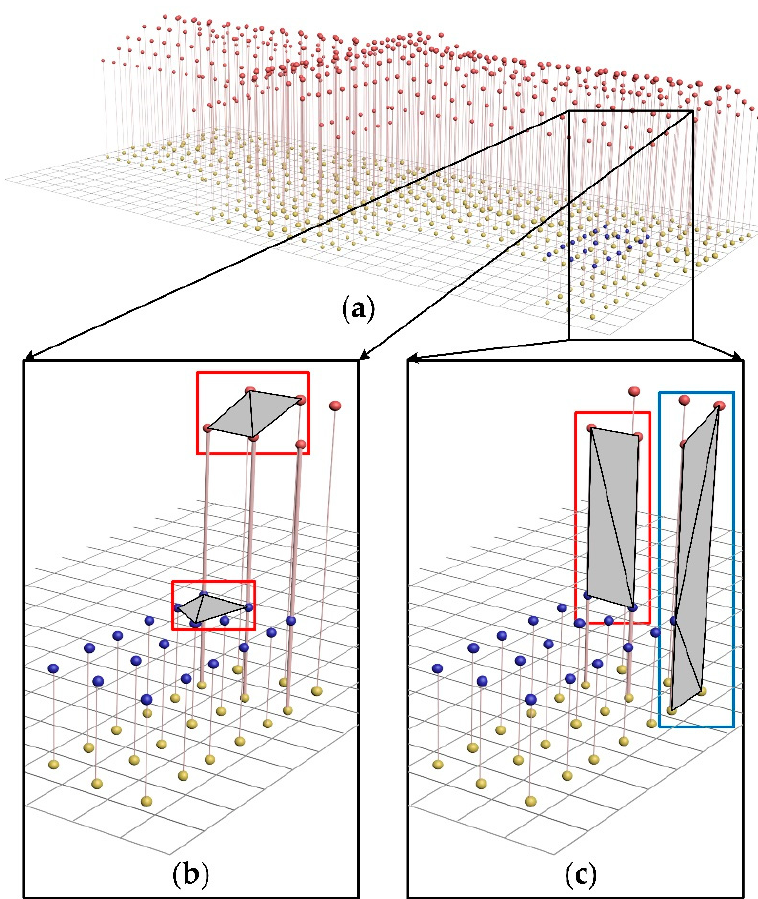
Figure 5. An example of building model reconstruction: ( a ) layer-connection points; ( b ) rooftop construction; and ( c ) wall construction.